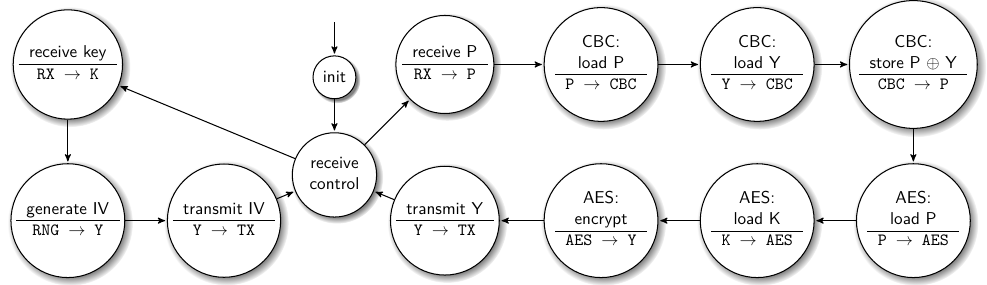
Figure 4: Functionality of the design. For readability, only transitions to other states are